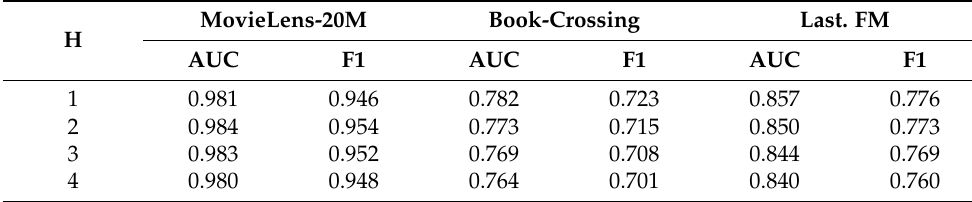
Table 8. Experimental performance of ATKGRM with different H values.